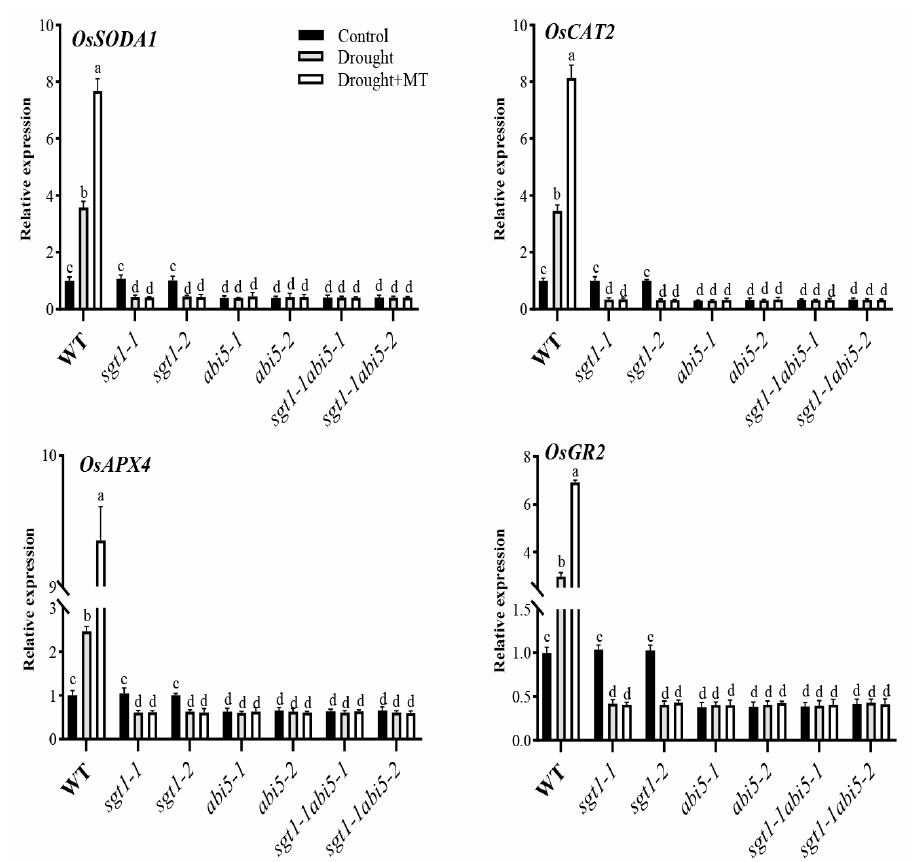
Figure 7. Effects of melatonin treatments on the expression level of antioxidative genes under drought stress. Expression of superoxide dismutase A1 ( OsSODA1 ), catalase 2 (OsCAT2), peroxisomal ascorbate peroxidase 4 ( OsAPX4 ), and g lutathione reductase 2 ( OsGR2 ) were examined in the leaves of wild-type (WT), sgt1 , abi5 and sgt1-1abi5 mutants treated with melatonin (MT; 100 µM) under drought stress. Di ff erence in letters indicates signi fi cant di ff erences according to Tukey’s Multiple Comparison Test ( p < 0.05).